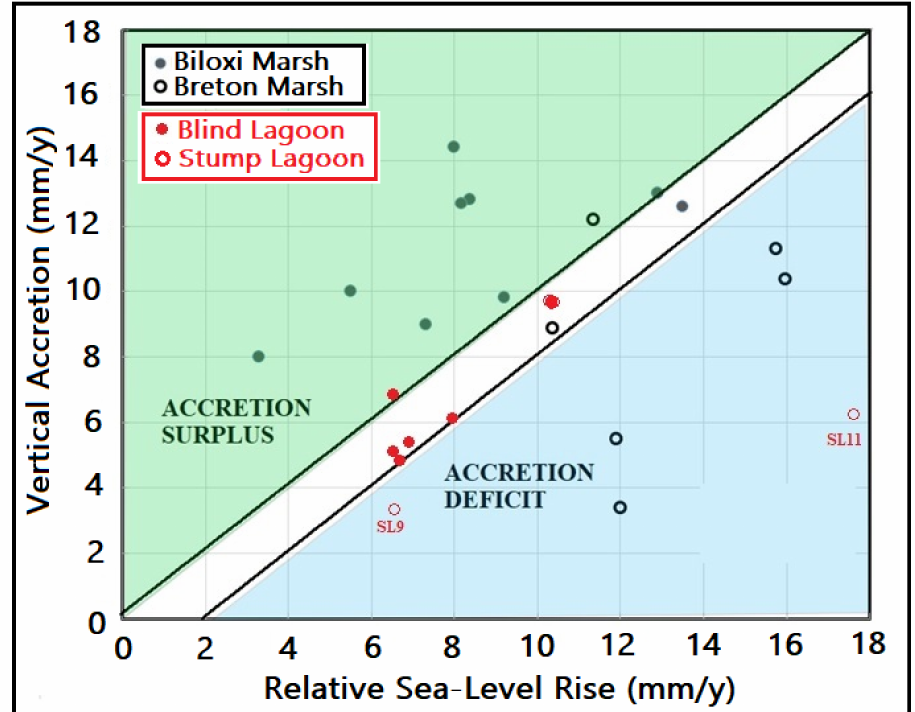
Figure 15. Jankowski marsh vulnerability (to submergence) diagram [67] for CRMS stations in Biloxi and Breton marshes averaged over the 2008 to 2018 decade (Table S3), and in red at UNO interior marsh sites (Table S4) over 1.5 decades at Stump and Blind Lagoons (Figure S3). Sites plotted above the 1:1 line in the green zone are sustainable, while those in the blue are not. Sites in the white “buffer” zone are maintaining elevation relative to RSLR but may not be able to sustain a higher rate in the